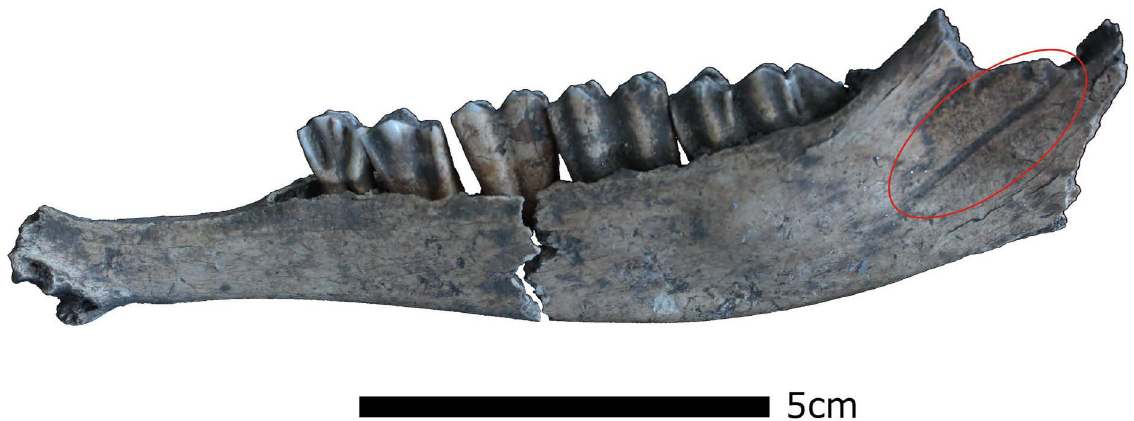
Figure 3. Ovicaprini mandible with a cut mark produced by a metallic